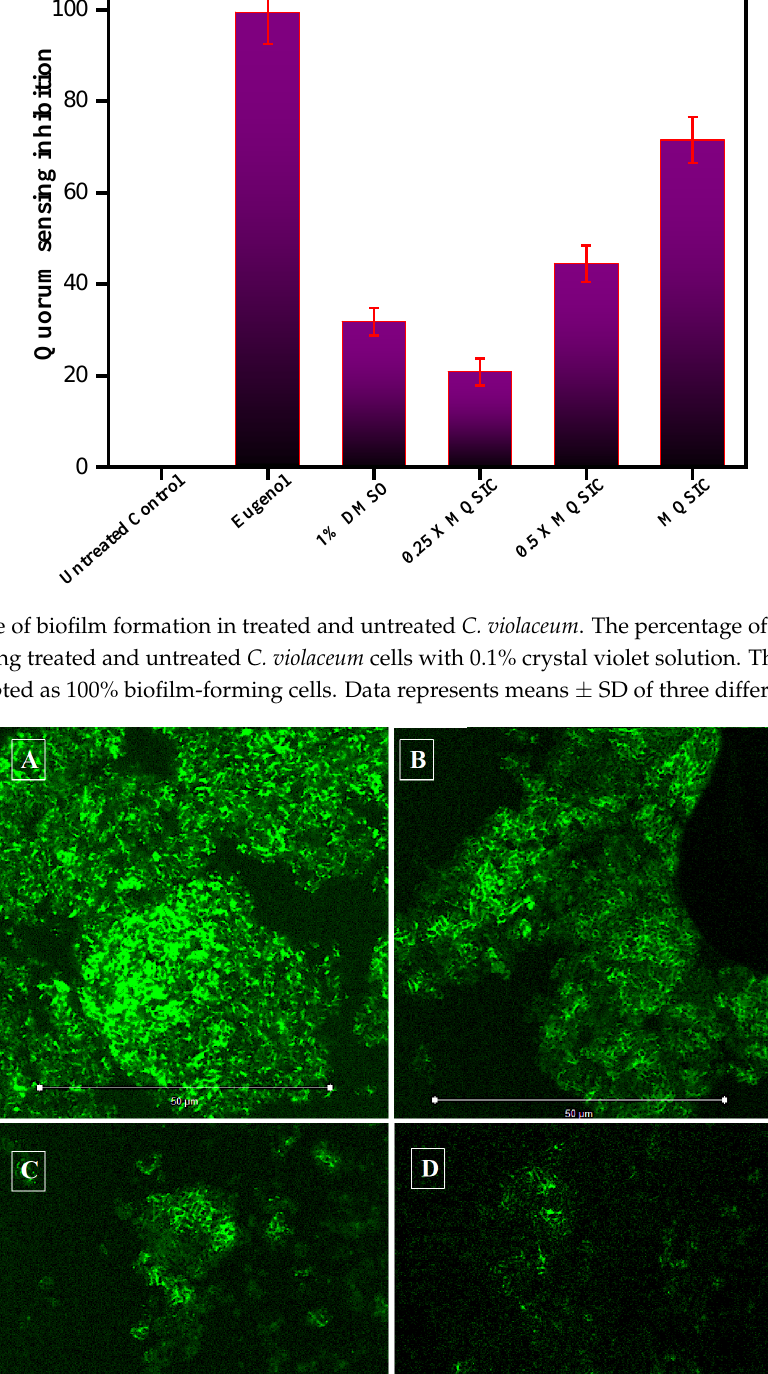
Figure 11. Confocal images of C. violaceum biofilms. The figure represents the efficacy of the biogenic ZnO NPs in preventing biofilm formation in C. violaceum . ( A ) Untreated control ( B ) 0.5 × MIC of ZnO NPs ( C ) MIC of ZnO NPs ( D ) 2 × MIC of ZnO NPs.